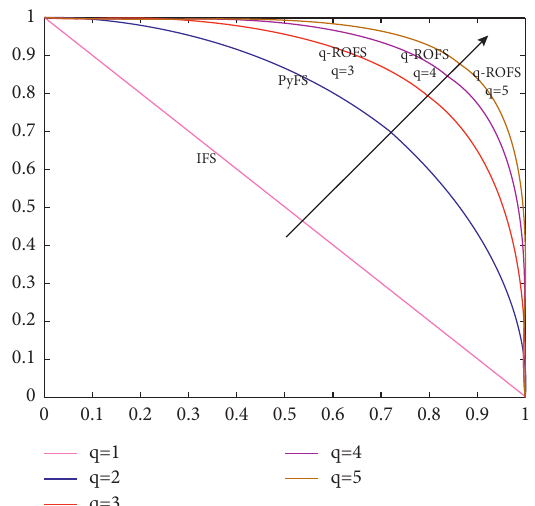
Figure 2: Geometrical representation of IFS, PyFs, and q -ROFSs ( q �